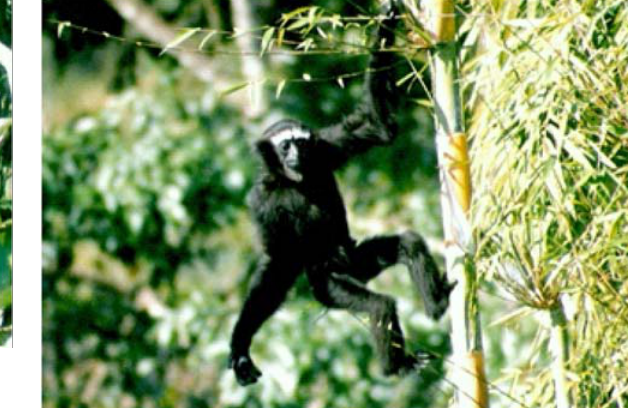
Image 4. Female carrying newly born infant.